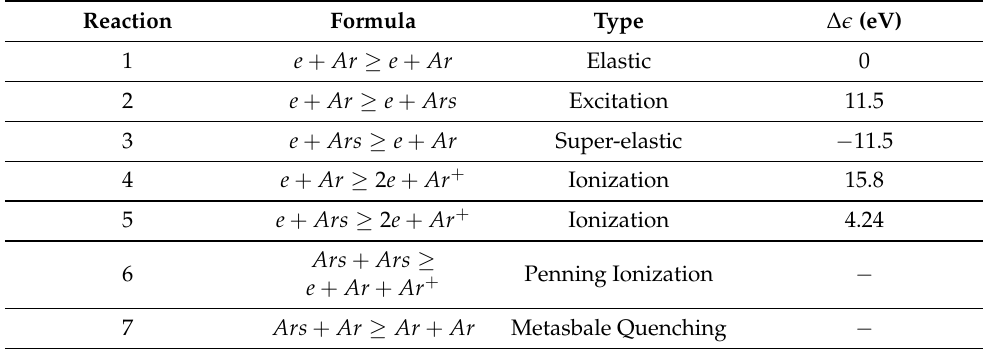
Table 2. Modeled collisions and reactions.